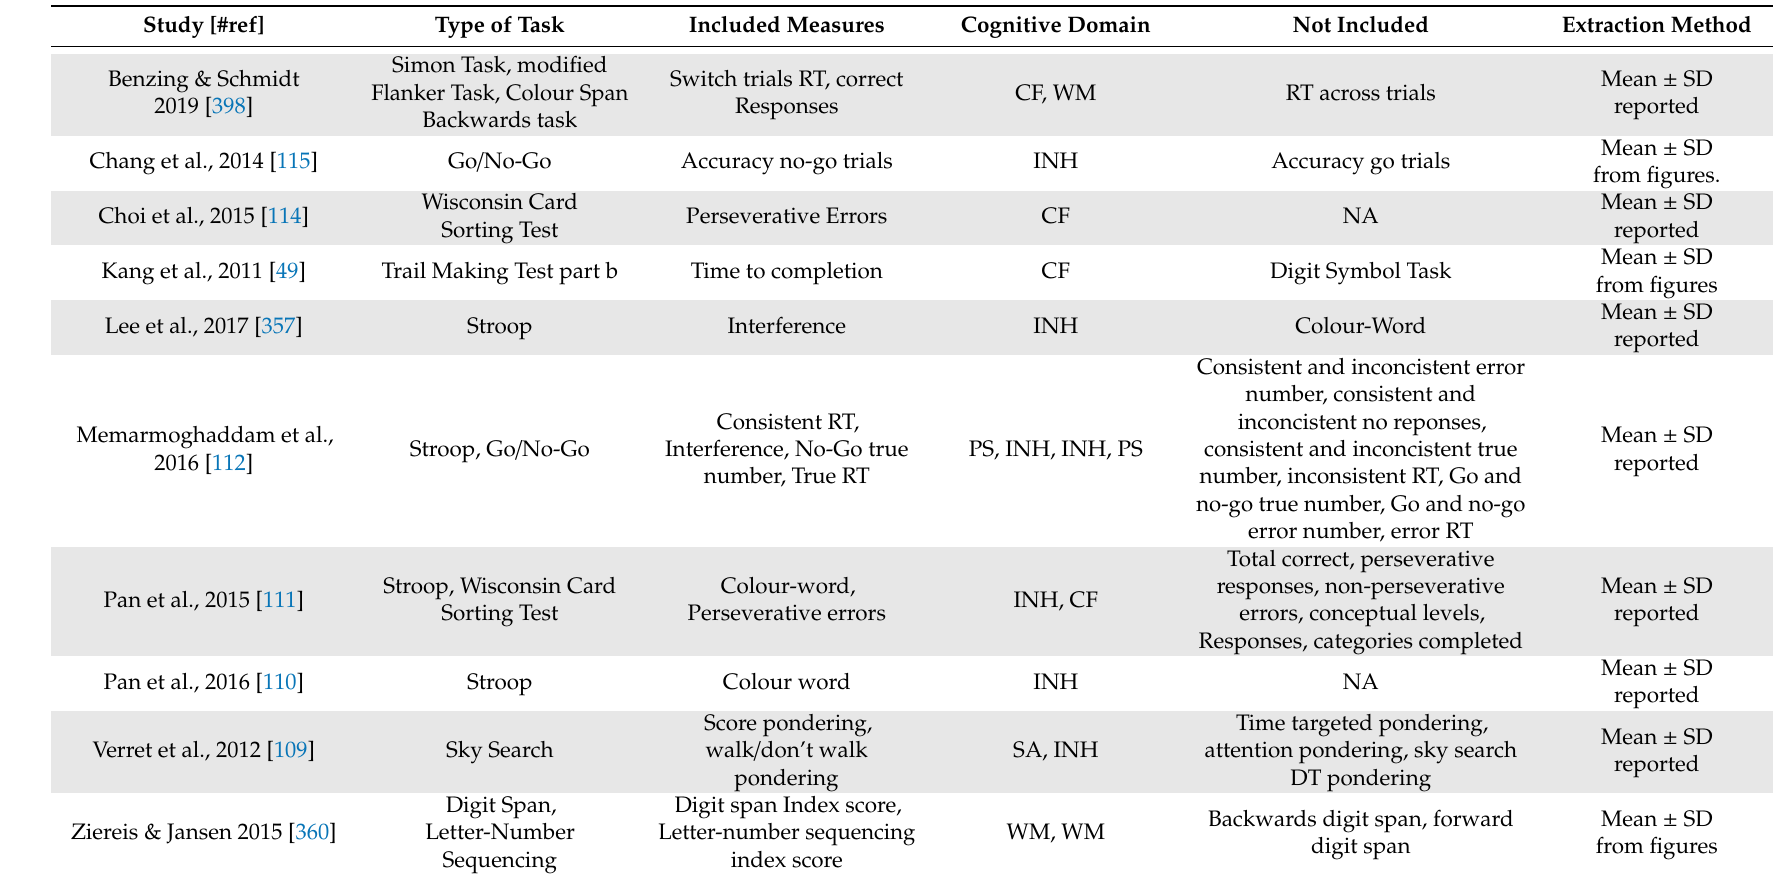
Table A2. Included and excluded dependent variables from chronic